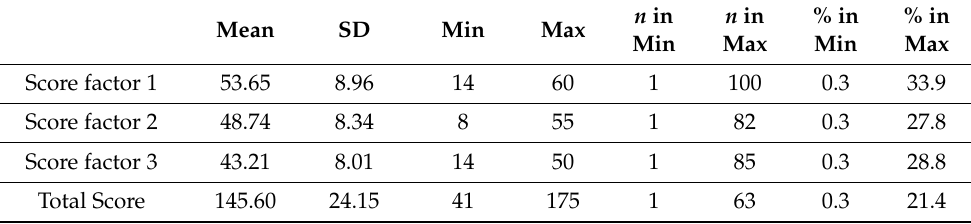
Table 3. Floor and ceiling effects: percentage of values in the minimum and